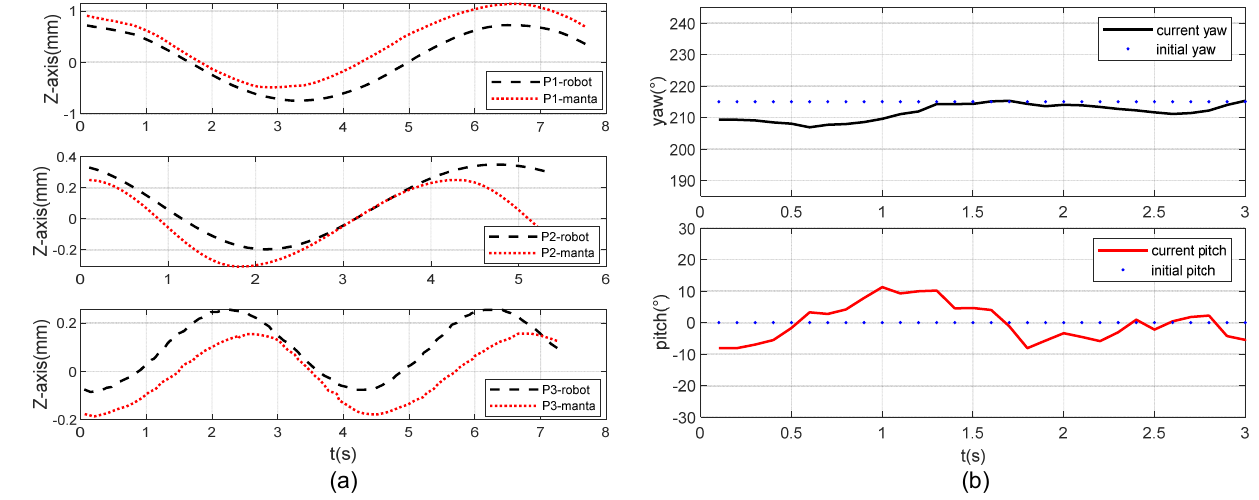
Figure 9. Experimental results of forward swimming. ( a ) Motion sequence diagram of manta robot with the pectoral fin feature points of a manta ray; ( b ) Performance of forward swimming.